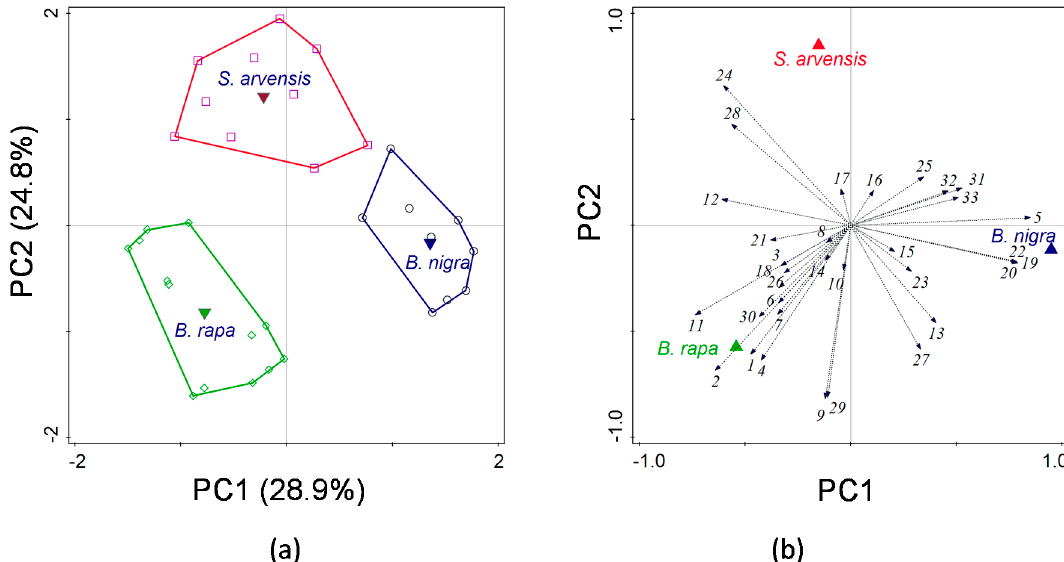
Figure 6. Principal component analysis (PCA) on the quantitative data of volatile compounds emitted by Brassica rapa ( n = 13), Sinapis arvensis ( n = 10), and Brassica nigra ( n = 9) plants in response to Pieris brassicae feeding for 24 h. The score plots of the samples ( a ) depict separation of the different plant species along the first and second PC with the explained variance between brackets. The corresponding loading plot of the variables ( b ) shows the contribution of each volatile compound to the first two PCs and the sample groups (here plant species). For the identity of compounds presented as numbers in the loading plot ( b ), please refer to Table